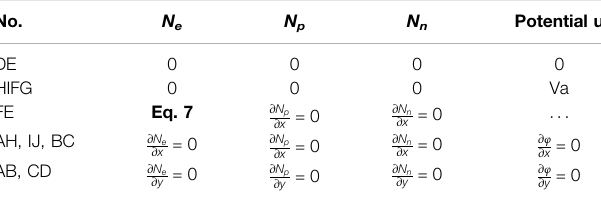
TABLE 2 | Boundary conditions on potential φ and species density ( N e , N p , N n ) in Figure 1A .